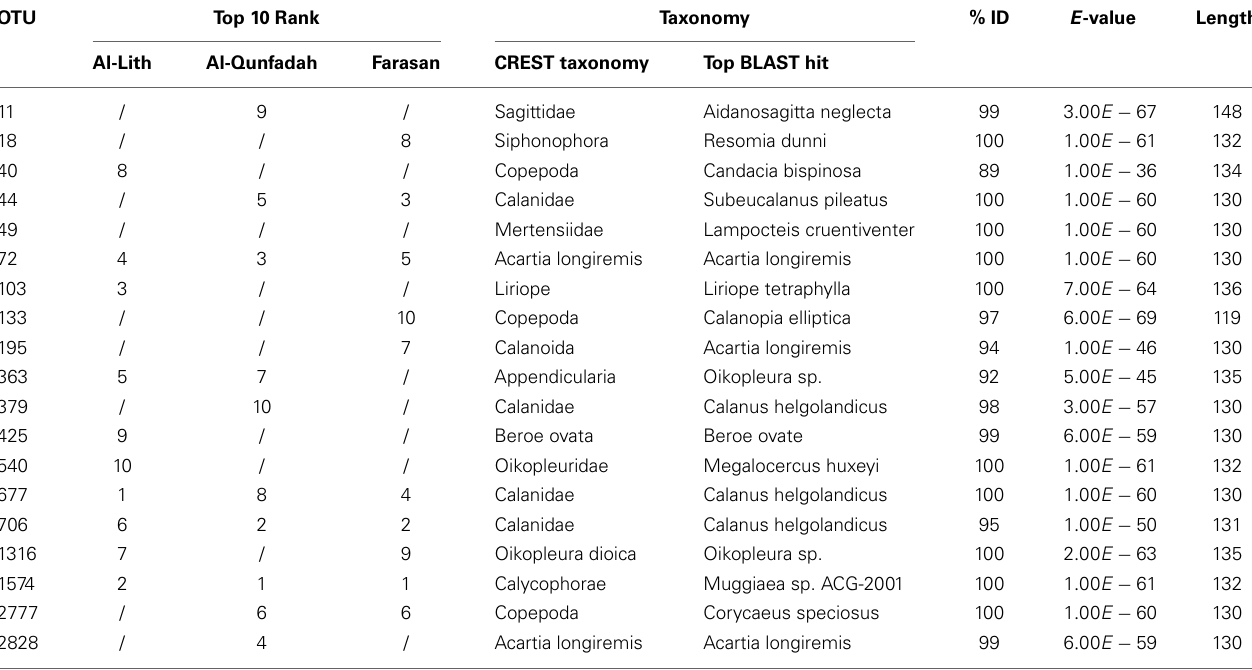
Table 4 | Ranking of OTUs (only top 10 of each reef) based on abundance for the three reefs for the 1389F primer. OTU Top 10